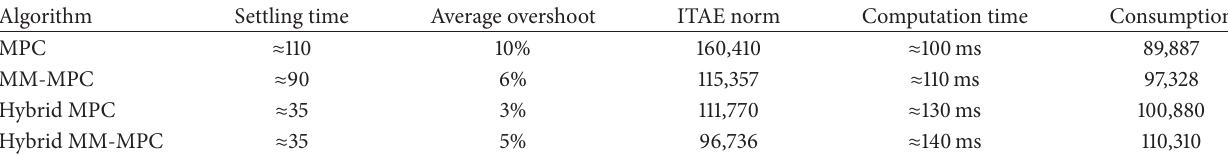
Table 2: Comparisons of the proposed MPC